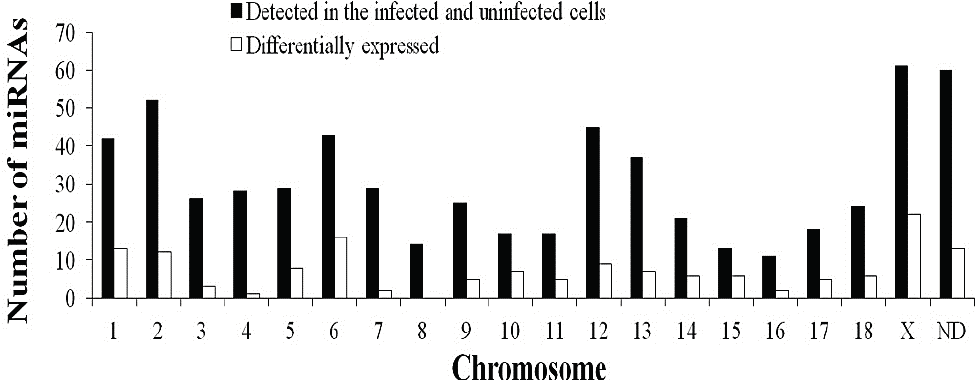
Figure 3. Chromosomal locations of miRNAs based on the numbers of total miRNAs (detected in the infected and uninfected cells) and differentially-expressed miRNAs. “ND” means that the genome location of the pre-miRNA has not been